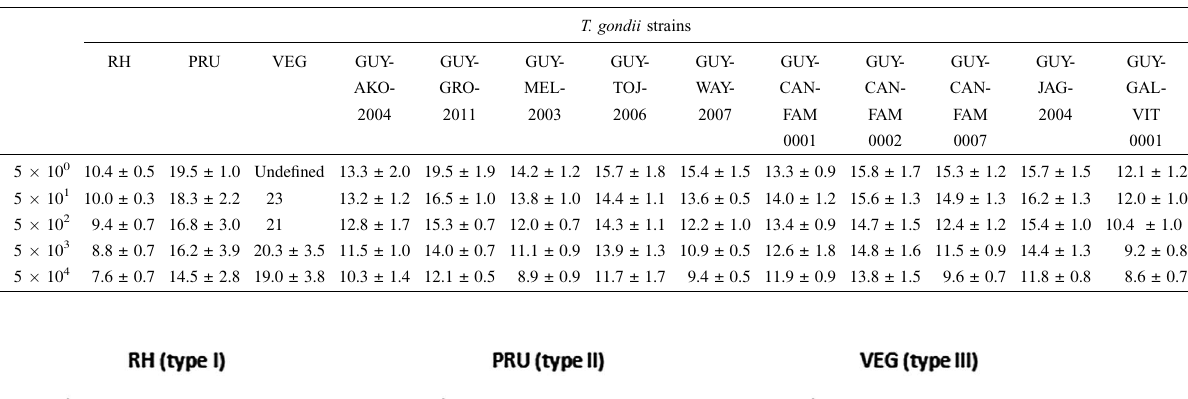
Table 2. Median survival days (± SD ) of mice inoculated with different doses of parasites.